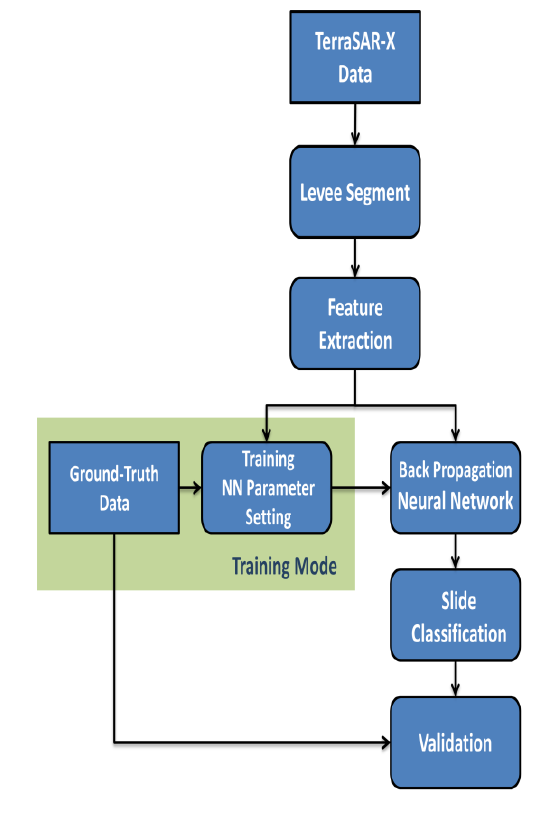
Figure 5. TerraSAR-X radar data (HH polarization) overlaid with masks for training (a) and testing